Question: Express in one sentence what the figure is showing.
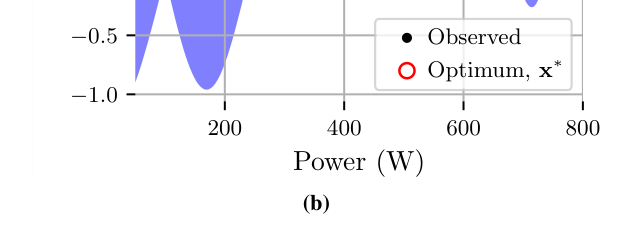
Answer: The plot in Fig. 9a illustrates the plots of the derivative of stress with pressure, gpr(x) against power. Similarly, Fig. 9b illustrates the GP fit of the objective function f(x) based on observations at D. Fig. 9b presents the variations of the posterior mean, µpos(x), (as a dashed line) and the standard deviation, σpos(x), (as a shaded area) with power. with the posterior mean represented and the standard deviation The peak value of the objective function is identified at the point (2 mTorr,620 W). Both plots are shown for the pressure 2 mTorr, after 10 iterations.